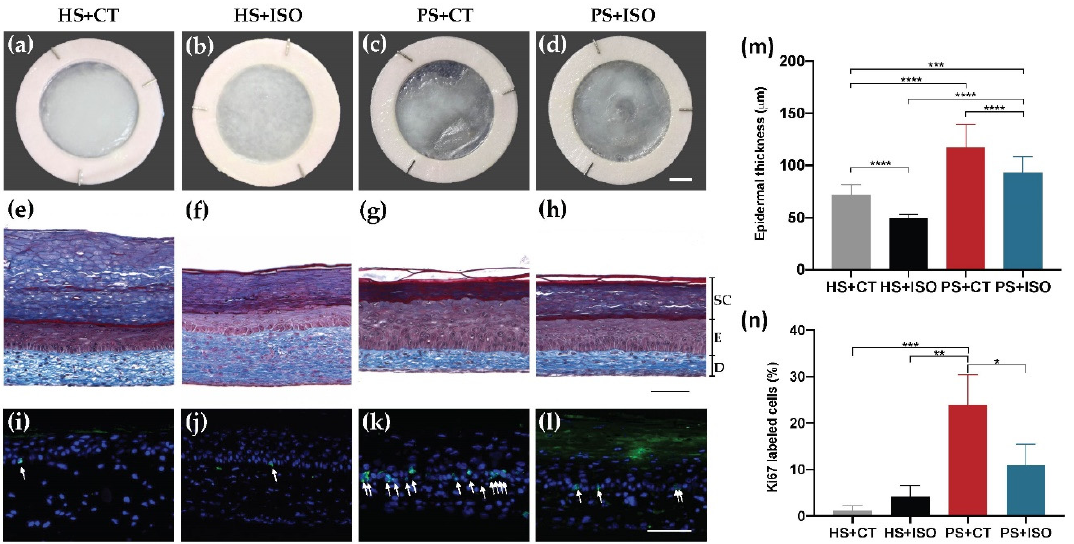
Figure 2. Morphology and epidermal proliferation of healthy substitutes (HS) and psoriatic substitutes (PS) produced with cholera toxin ( + CT) or isoproterenol ( + ISO). ( a – d ) Skin substitute macroscopic aspects; ( e – h ) Masson’s trichrome staining of skin substitute histological sections (D: Dermis, E: Epidermis living layers, SC: Stratum corneum ); ( i – l ) Ki67 immunofluorescence (green) detecting keratinocytes in proliferation. White arrows indicate Ki67-positive cells. Nuclei were stained with Hoechst (blue); ( m ) quantification of the thickness of the epidermal living layer (designated as E in panels ( e – h ) measured from Masson’s trichrome staining using the ImageJ software; ( n ) ratio of Ki67 positive cells to the number of total keratinocytes in the basal layer. Scale bars: ( a – d ) 5 mm; ( e – h ) 100 µ m. Data presented are the means + SD ( N = 2 donors per condition, n = 3 skin substitutes per donor). The statistical significance was determined using one-way ANOVA followed by a Tukey’s post-hoc test. (* p -value < 0.05; ** p -value < 0.01; *** p -value < 0.001; **** p -value < 0.0001).